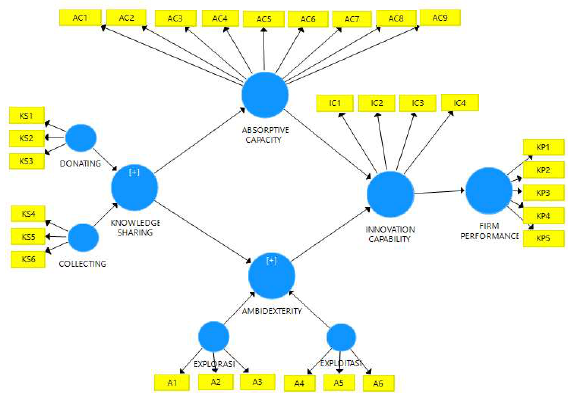
Fig. 2. The results of outer